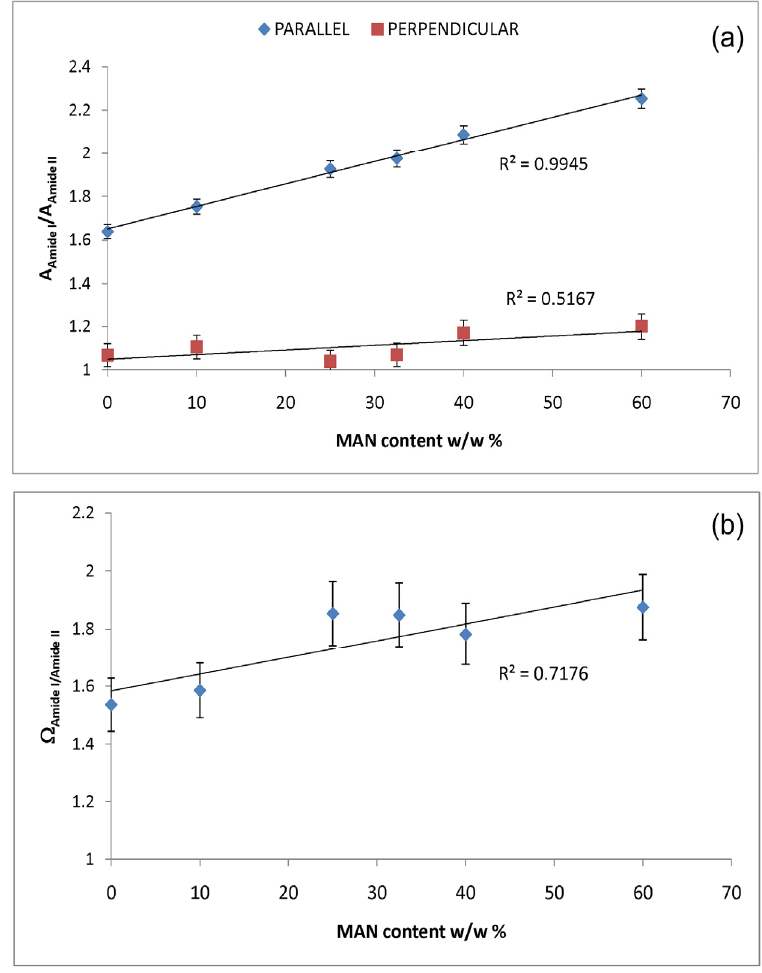
Figure 8. Trend of the IR A Amide I /A Amide II absorbance ratio ( a ) in the parallel and perpendicular spectra and Ω Amide I/Amide II marker ( b ) as a function of the MAN content ( w / w %).